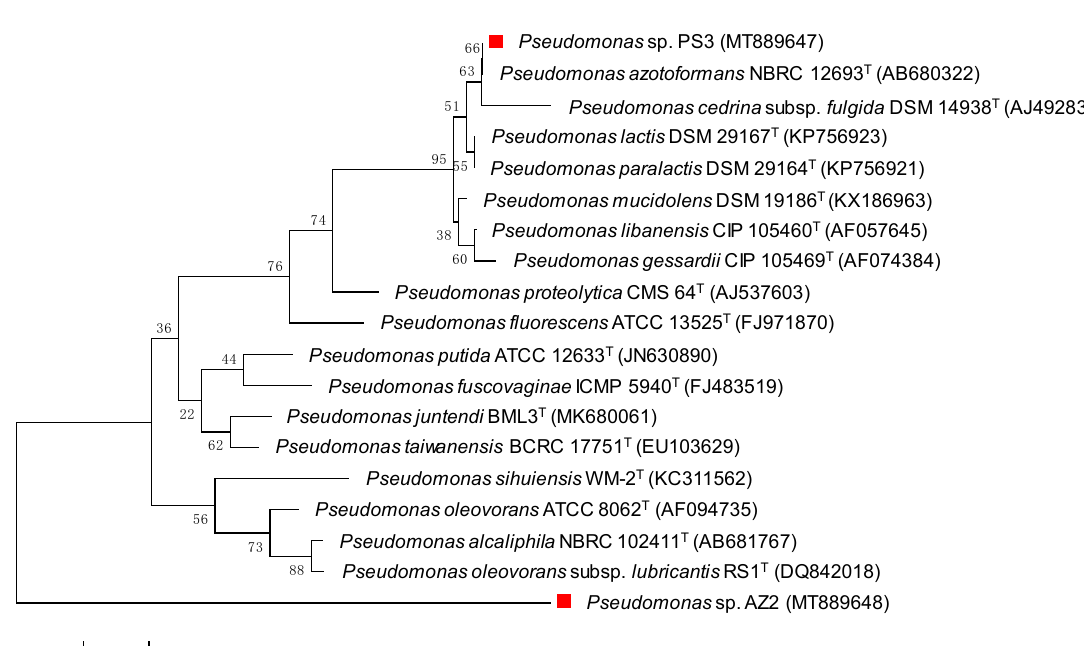
Figure 2. Unrooted neighbour-joined phylogenetic tree of two plant growth-promoting rhizobacteria (PGPR) Pseudomonas sp. PS3 and Pseudomonas sp. AZ2 isolated from cabbage and mustard rhizospheres. The tree was constructed based on 16S rRNA partial gene sequence of selected PGPR (marked with red square) and closely related phylogenetic species (type cultures) derived using NCBI BLAST search tool. Sequences were aligned using Clustal W sequence alignment tool in MEGA 7.0 software. The GenBank accession numbers of isolates and closely related species are presented in parenthesis. Bootstrap percentage values as obtained from 1000 replications of the data set are given at the tree’s nodes. The scale bar corresponds to the mean number of nucleotide substitutions per